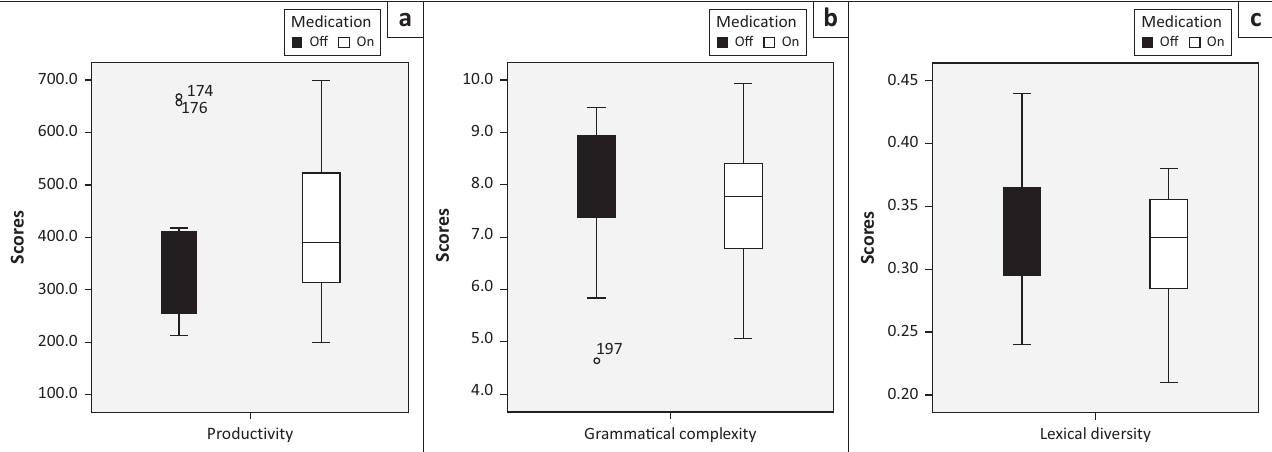
FIGURE 1: Boxplots representing the median and interquartile ranges for microstructure elements, off and on medication for (a) productivity (number of words), (b) grammatical complexity (mean length of utterance) and (c) lexical diversity (type–token ratio).